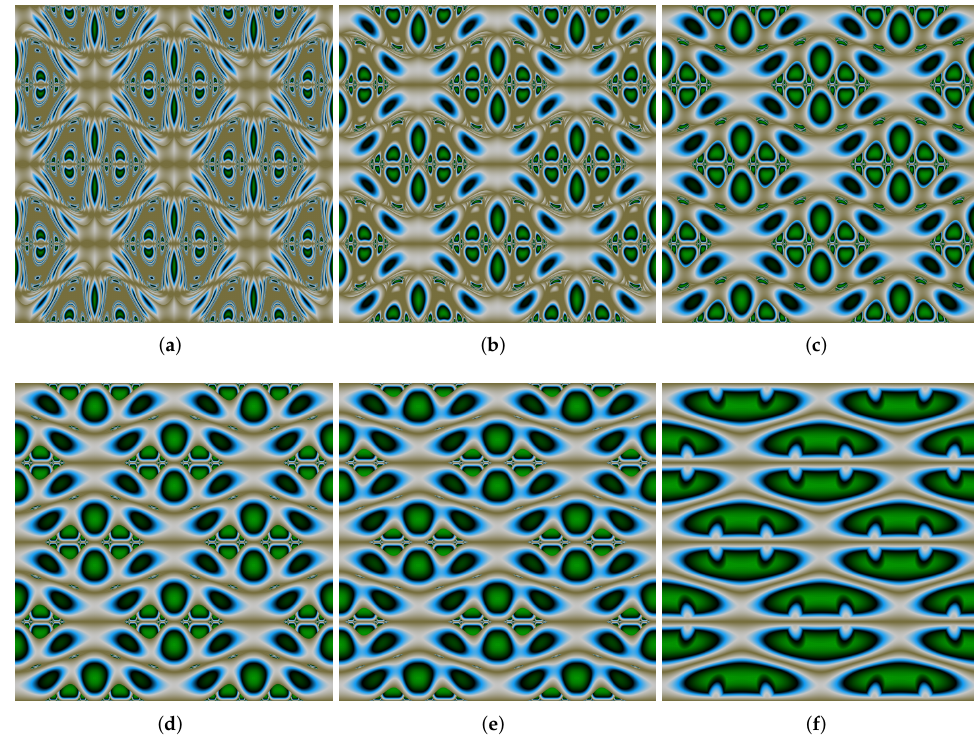
Figure 6. Patterns generated with function f with cmm symmetry and orbit traps from Figure 3a with various values of p in the l p metric. ( a ) l 1.0 ; ( b ) l 1.5 ; ( c ) l 2.0 ; ( d ) l 2.5 ; ( e ) l 3.0 ; and ( f ) l ∞ .